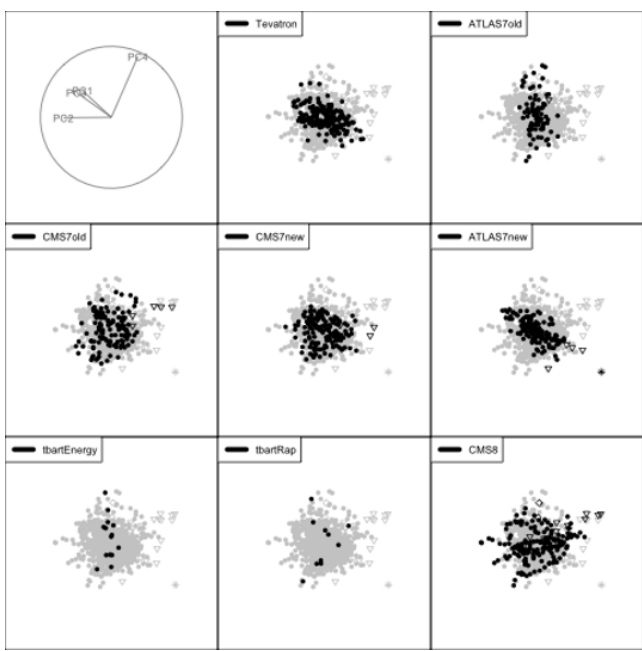
Figure 3. Example projection of the jets dataset viewed with the tour, see here for full animation. The points are grouped by experimental analysis, and selected kinematic regions are highlighted with di ff erent marker symbols. We can identify multivariate outliers from the